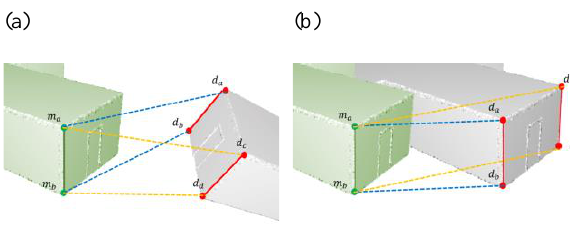
Figure 2 . Visualization of pair of as-planned corner points having possible congruency with two pairs of as-built corner points (a) before transformation scrutiny and, (b) after complete geometric assessment.